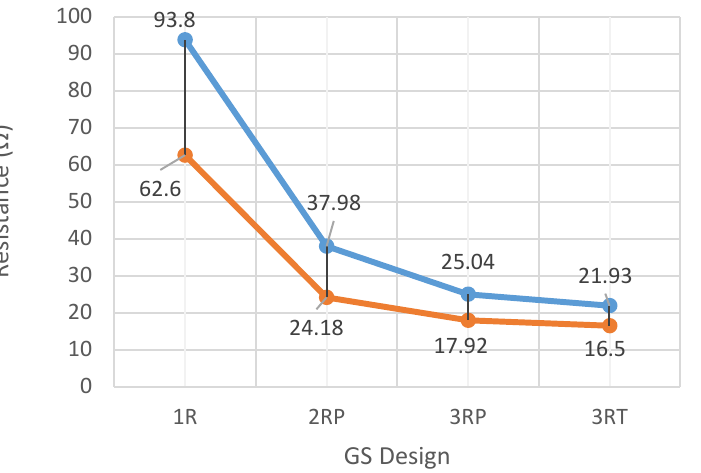
Figure 15. GR vs. GS design in S3.